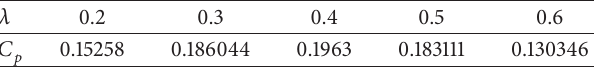
Table 2: Power coefficient ( 𝐶 𝑝 ) versus tip speed ratio 𝜆 .